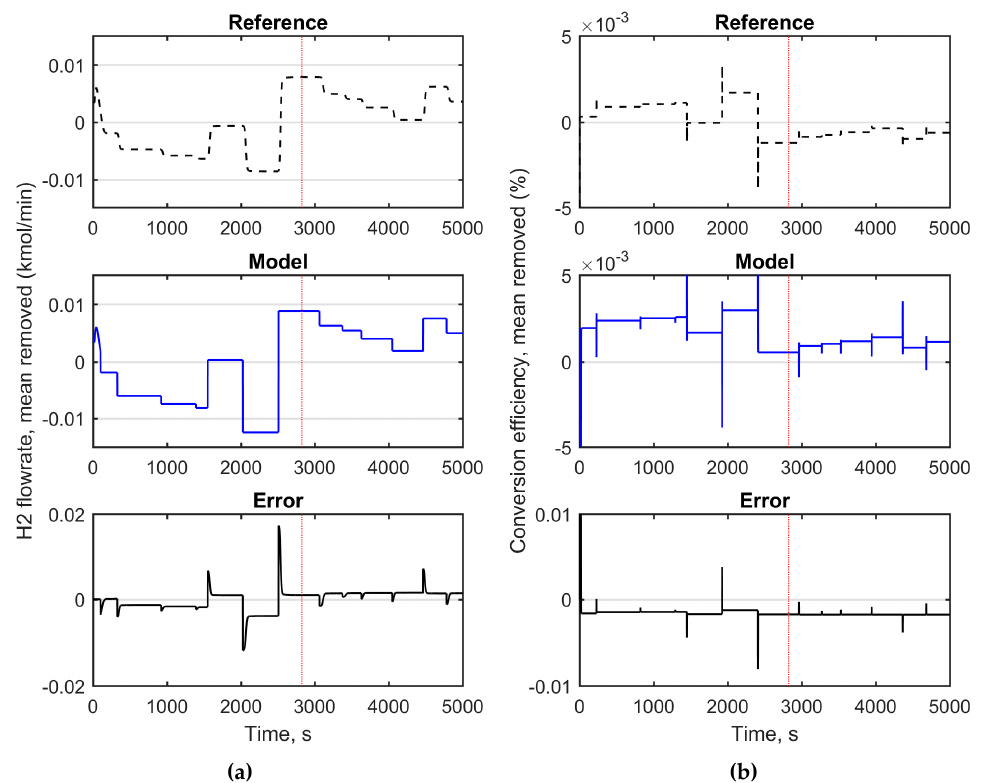
Figure 5. Simulated model outputs of multiple-input multiple-output ARX-model. ( a ): hydrogen flow rate, ( b ): conversion efficiency. Solid line: model outputs, dashed line: simulated true value, dotted line: division of training (on right), and testing data (on left).